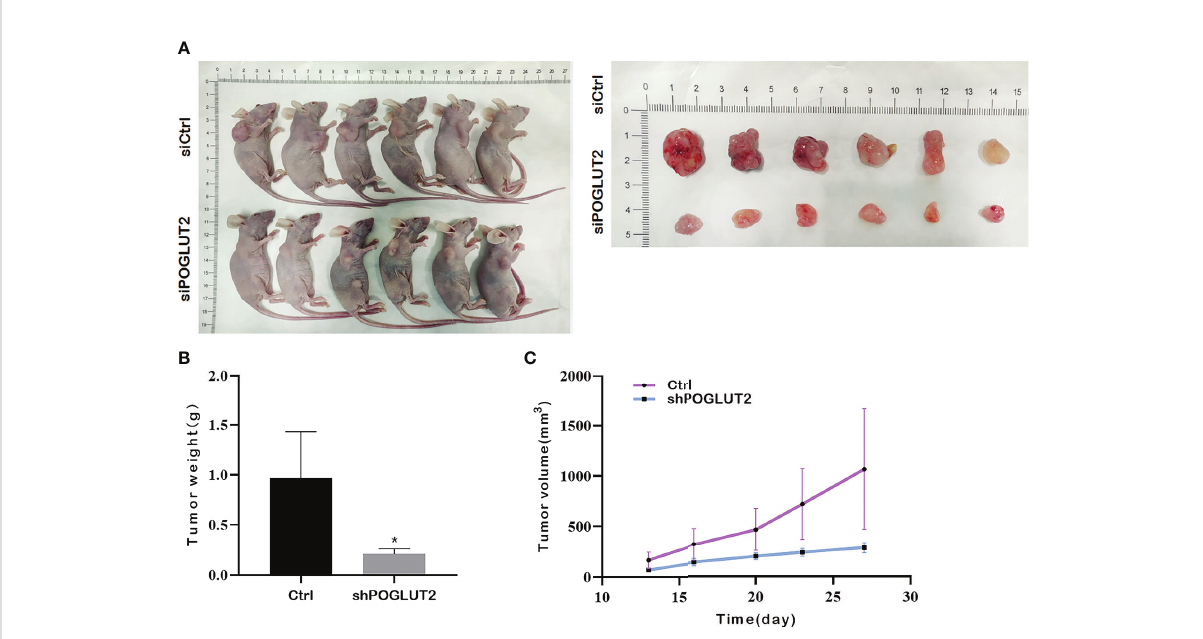
FIGURE 11 POGLUT2 knockdown decreased the tumor growth in a xenograft transplantation model. (A) Photographs of tumor-bearing nude mice and